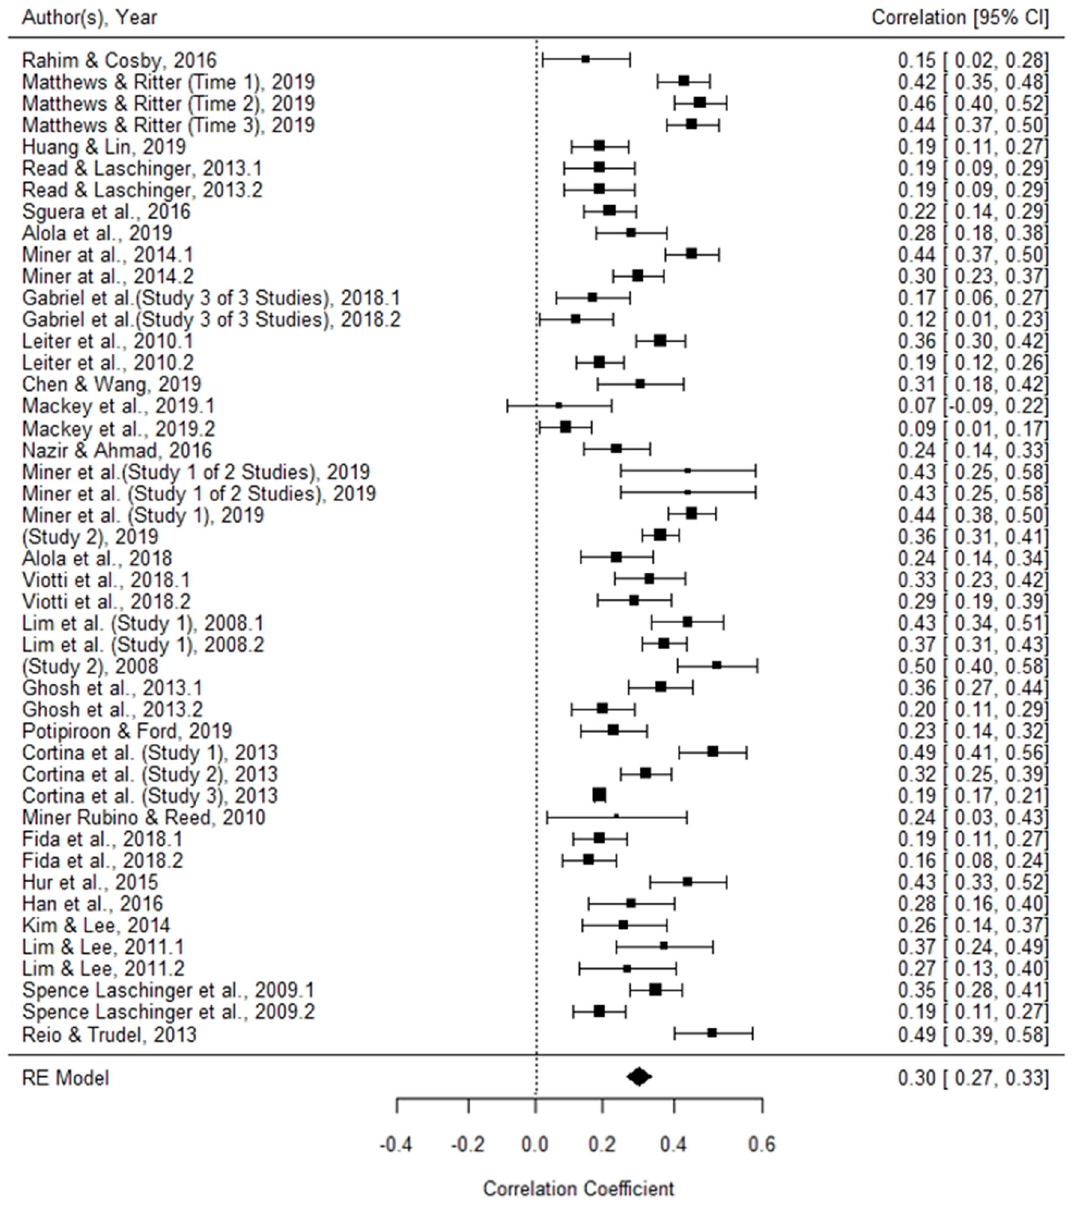
Figure 3. Forest plot for all studies included. Each point estimate (black square) bounded by a 95% CI, represents one study included in the meta ‐ analysis. The black rhombus at the bottom of the plot represents the summary effect size and its width displays the 95% CI. Table 3. Meta-regression analysis for the different incivility groups of the